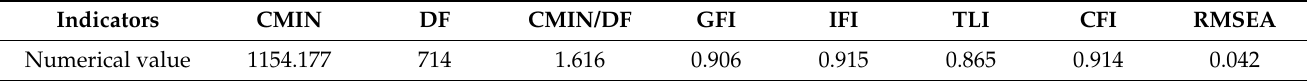
Table 7. Model fitting indicators.